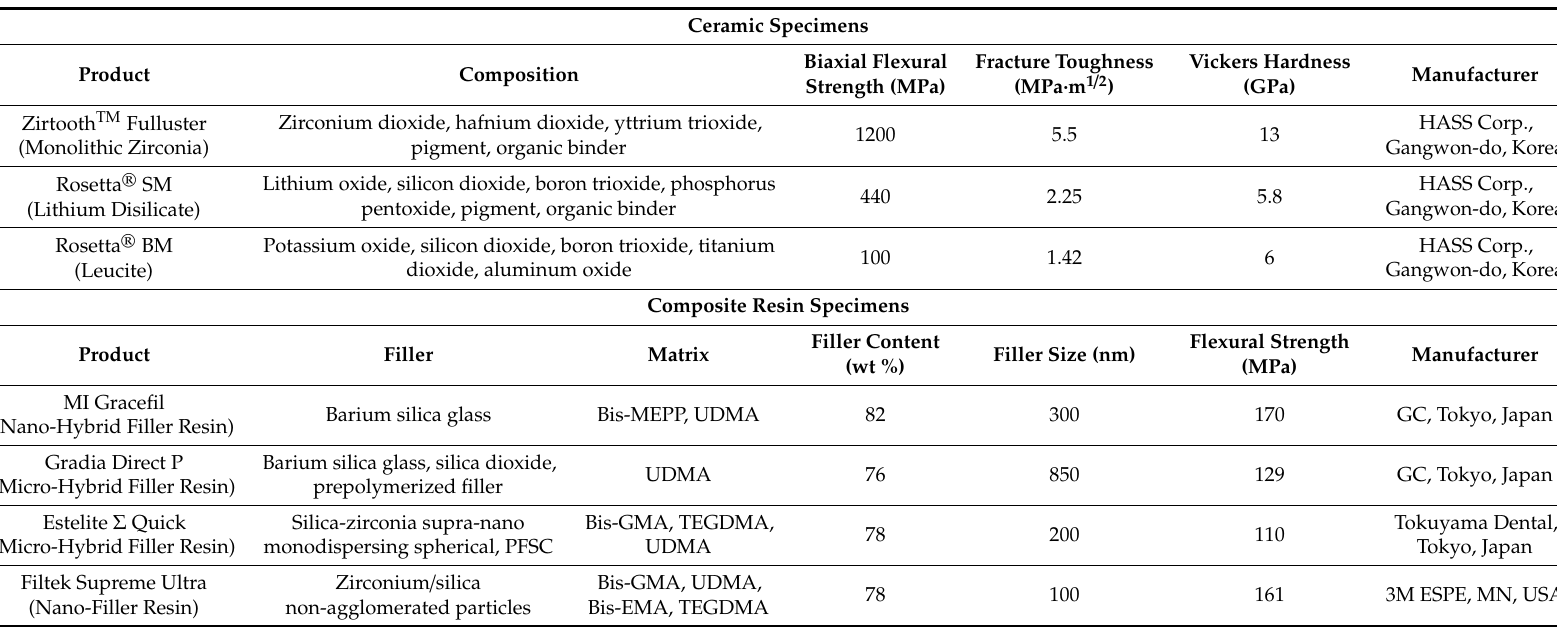
Table 1. List of materials used and their